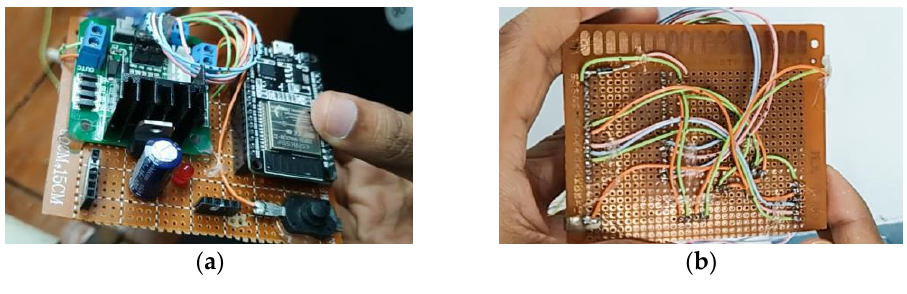
Figure 6. Our custom-made control unit: ( a ) front; ( b ) back.